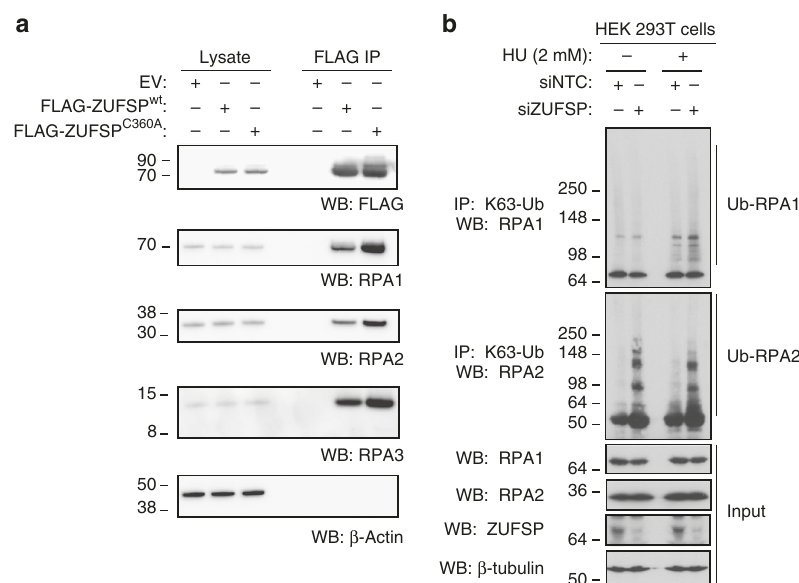
Fig. 7 ZUFSP interacts with and affects the ubiquitination of RPA proteins. a FLAG-immunoprecipitated material from HEK 293T cells expressing wild-type or catalytic mutant FLAG-ZUFSP, or empty vector (EV), was analyzed by western blotting. b HEK 293T cells transfected with siRNA targeting ZUFSP or a non-targeting control were treated with 2 mM hydroxyurea (HU) for 2 h. K63-linked Ub chains were immunoprecipitated and the enriched proteins were analyzed by western